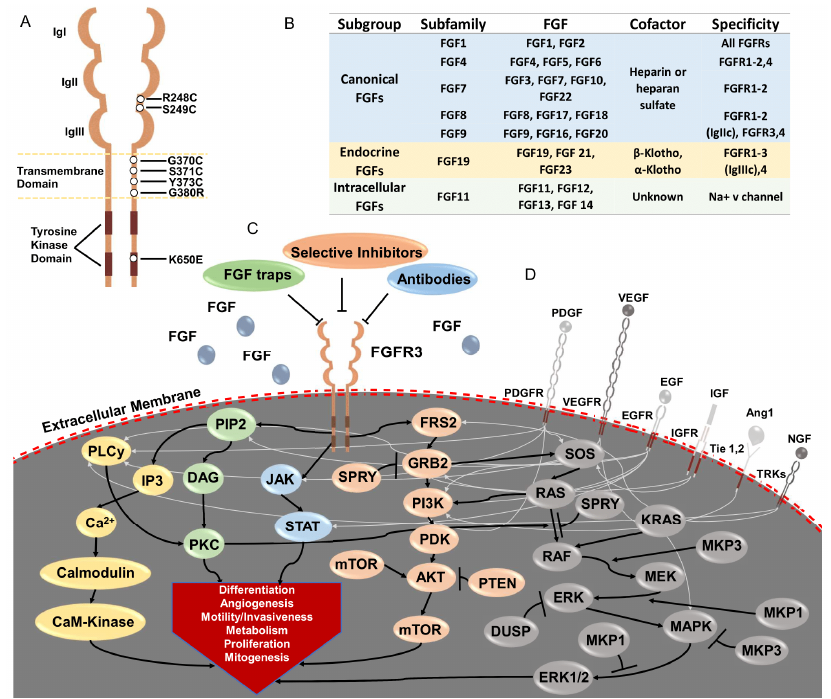
Figure 1. Overview of FGF/FGFR signaling and its dysregulation in advanced bladder cancer . ( A ) Basic structure of the fibroblast growth factor receptor (FGFR) family and activating mutations of FGFR3 found in advanced bladder cancer. FGFRs consist of an extracellular domain enclosing three immunoglobulin (Ig)-like domains (IgI, IgII and IgIII), a transmembrane domain, and two tyrosine kinase sub-domains. In advanced bladder cancer, activating missense mutations in FGFR3 are the dominant genetic alterations in the FGFR family proteins. These mutations are predomi- nantly in the ligand-binding (R248C and S249C) and transmembrane (G370C, S371C and Y373C) domains, mon. ( B ) Twenty-two FGFR ligands in human. FGFs can be categorized into 3 subgroups: 1) ca-